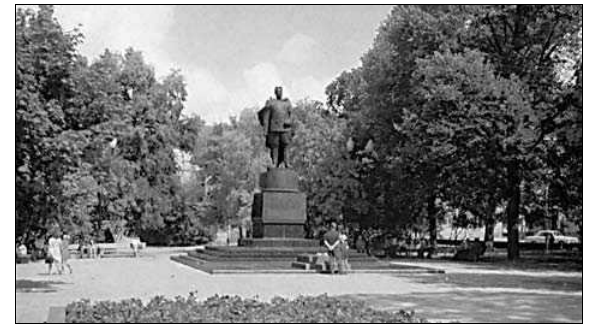
Fig. 4. Monument to Vincas kudirka. current